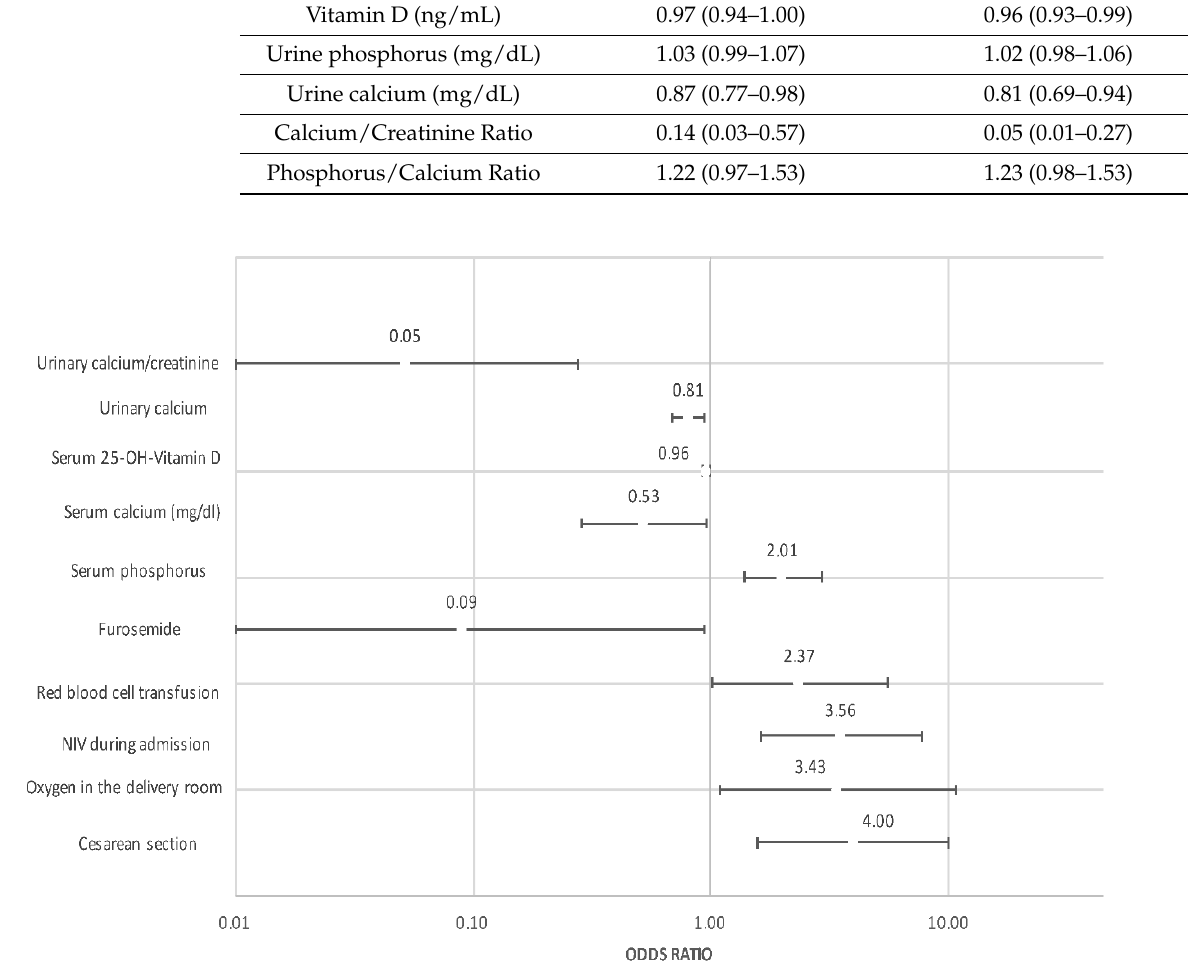
Figure 2. Graph representing odds ratio and 95% confidence interval of factors independently associated with HPTH.